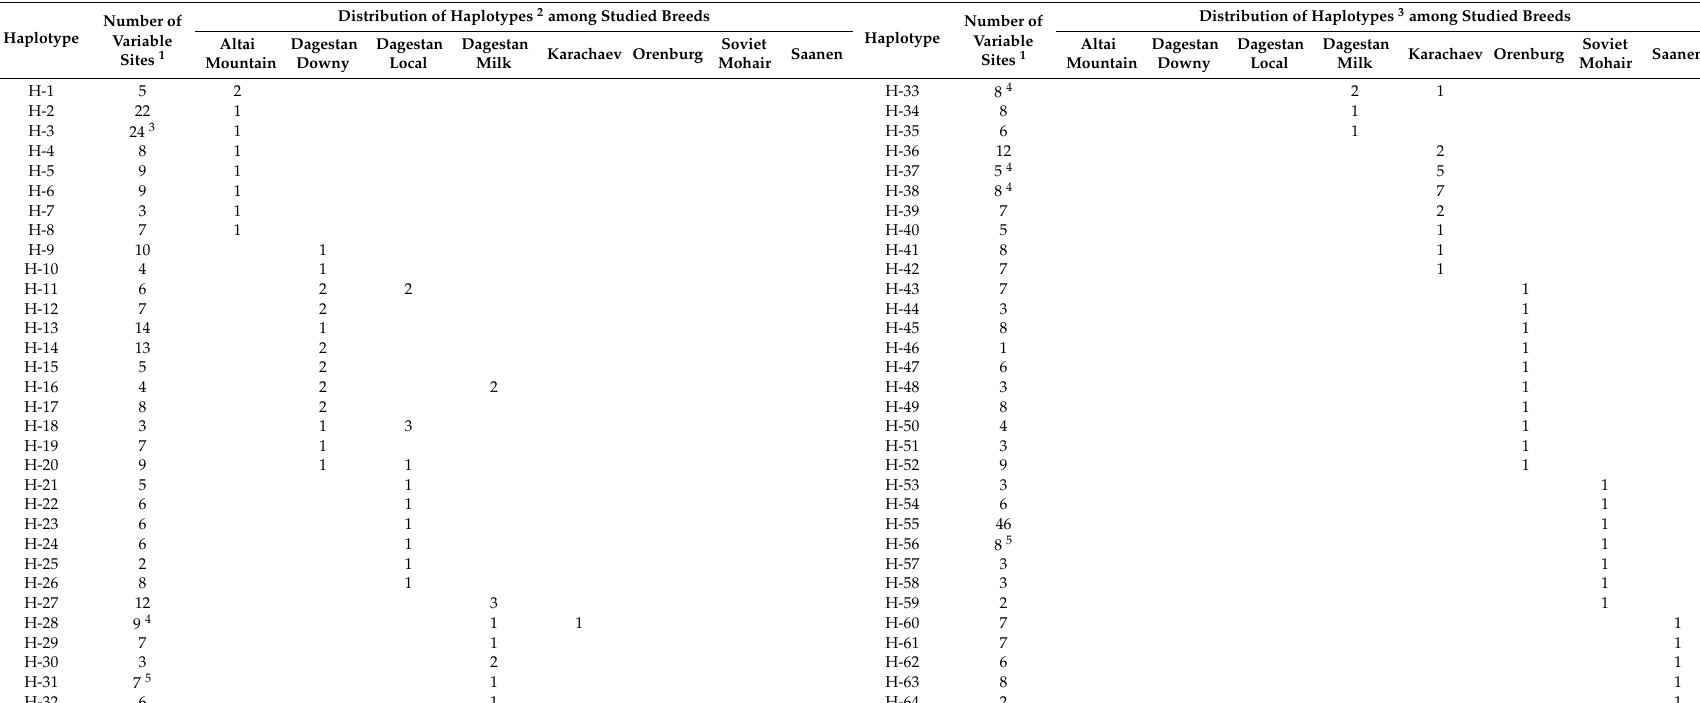
Table 3. Distribution of haplotypes among studied